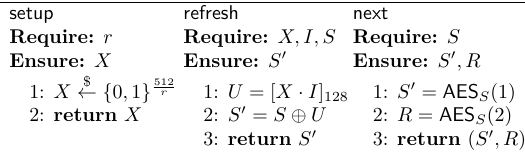
Figure 16: ROB ( F ): A Secure